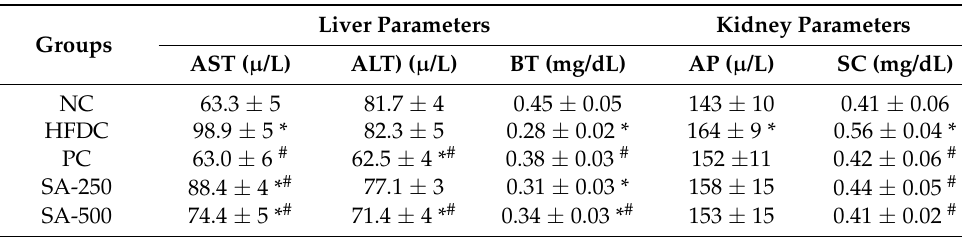
Table 5. Effect of star anise tea and orlistat treatment on the biochemical parameters of different groups of obesity rat model. Liver Parameters Kidney Parameters Groups AST ( µ /L) ALT) ( µ /L) BT